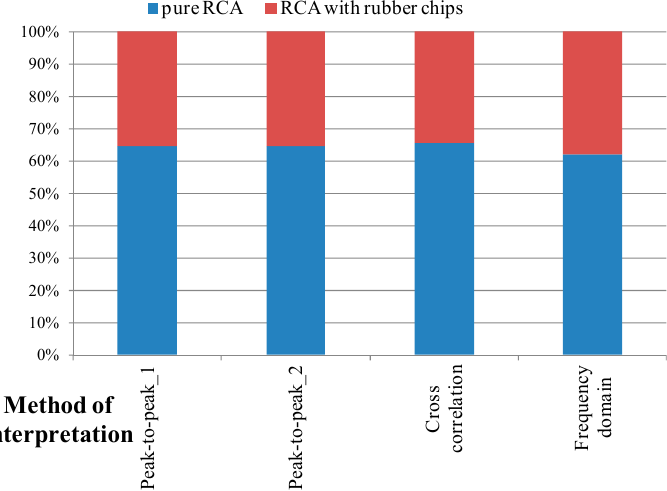
Figure 13. Percentage distribution of V S values between two different materials: pure RCA and RCA with rubber chips for p ′ = 45 kPa.